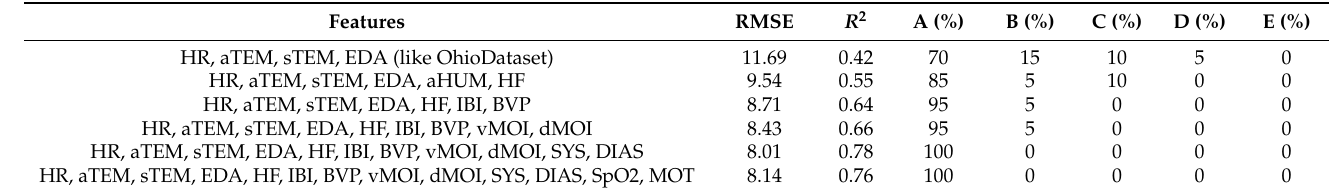
Table 6. Performance of the best-trained GPR model in unseen instances versus different noninvasive features for Subject 1 from the UofM dataset.